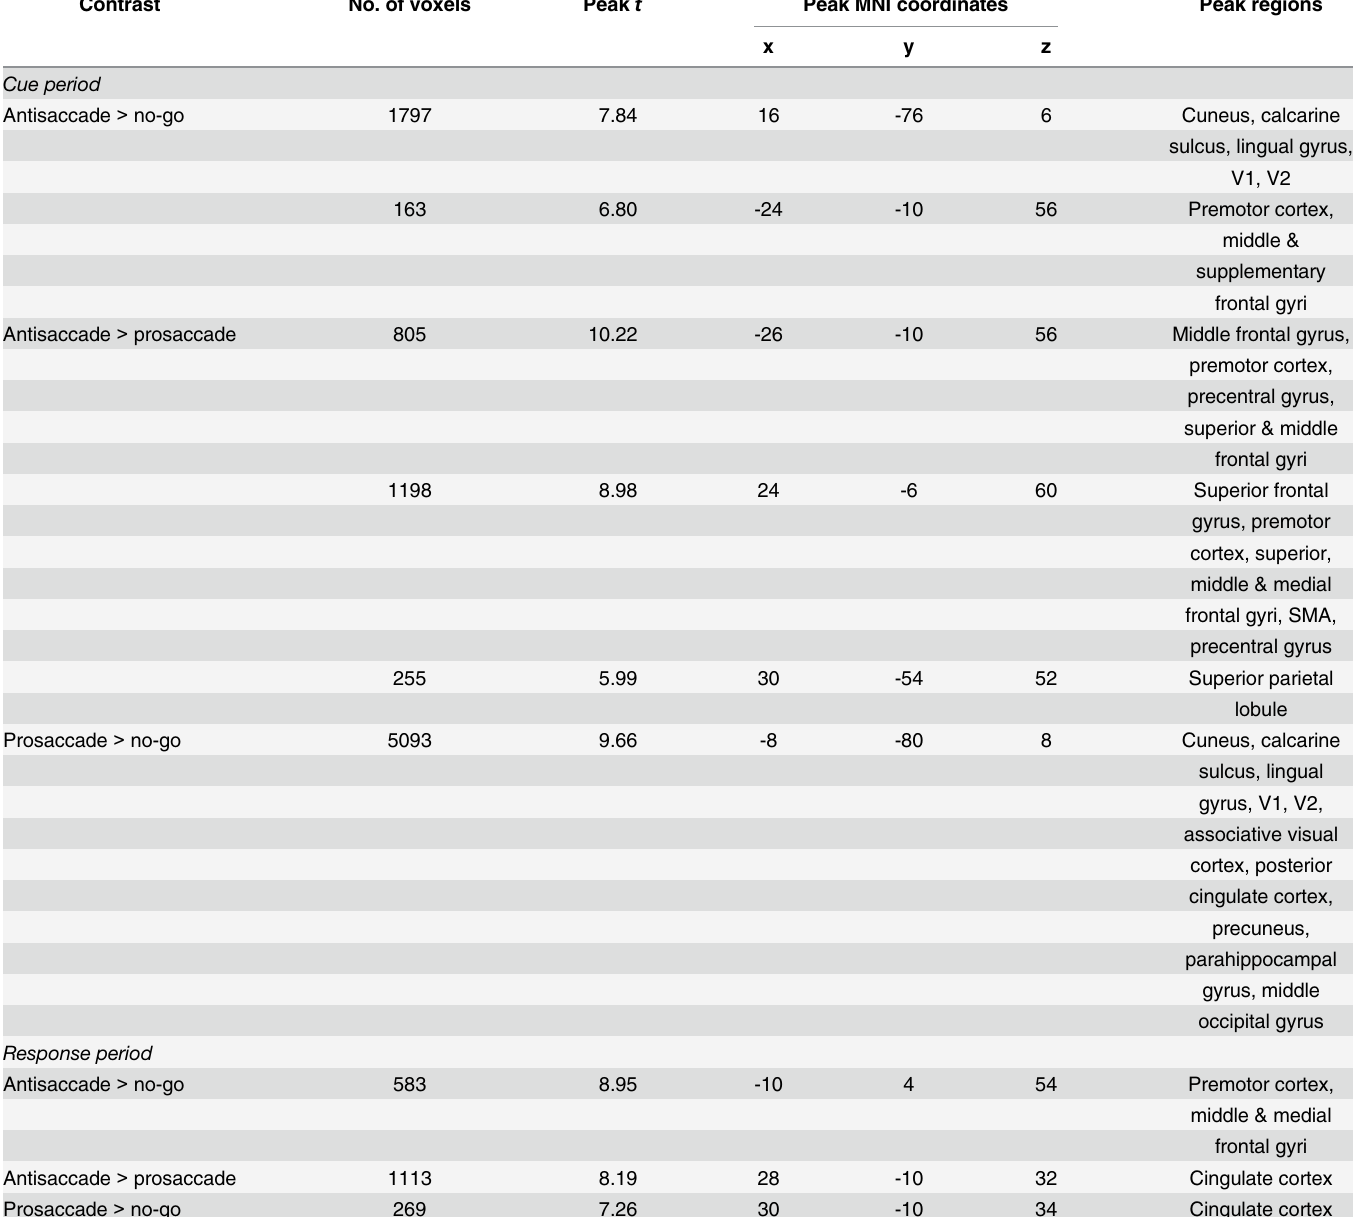
Table 7. Significant within groups contrasts for the Prosaccade/Antisaccade/No-Go task for control participants.